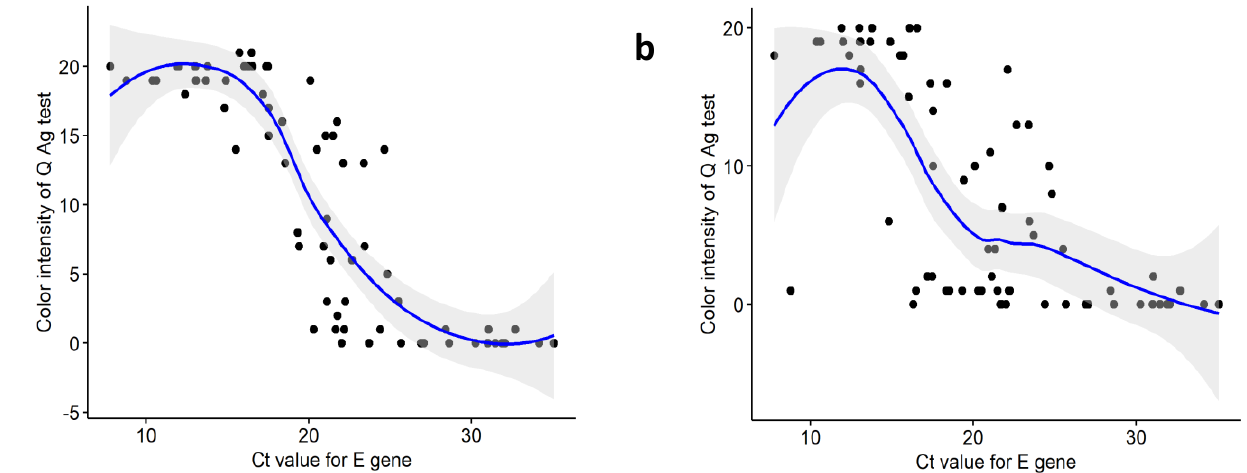
Figure 2. Spearman’s correlation analysis of the color intensity of the rapid antigen test (0: negative; 1: very weak; 21: very strong) and Ct values for the E determined by real-time PCR. ( a ) nasopharyngeal swab specimens (rho = − 0.876, p < 0.01), ( b ) nasal cavity swab specimens (rho = − 0.725, p < 0.01).